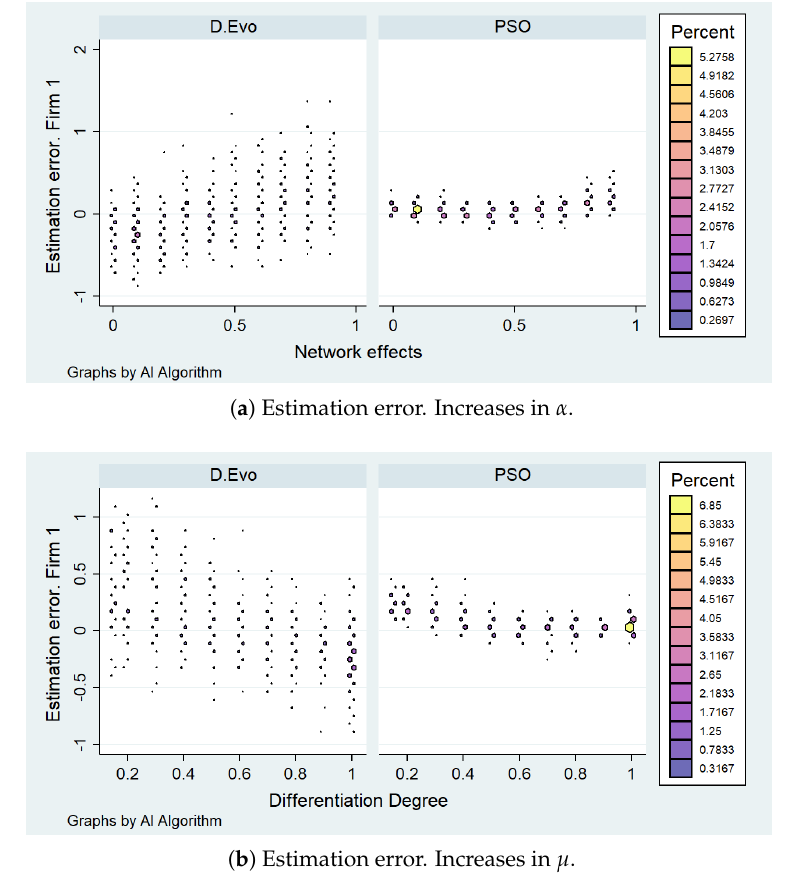
Figure 3. Price estimation by parameter. Left = network effects; Right = differentiation. Source: